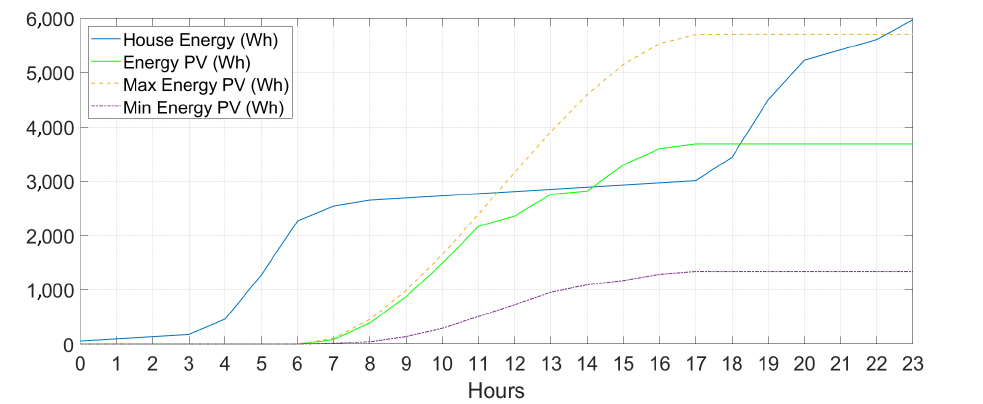
Figure 18. Profile 1 vs. 1 kW system